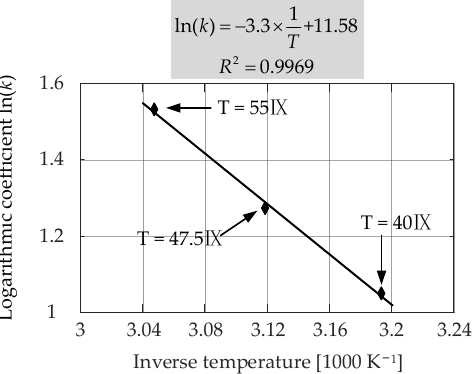
Figure 22. Arrhenius equation for determining the temperature dependence of resistance increase (at 50% SOC level).